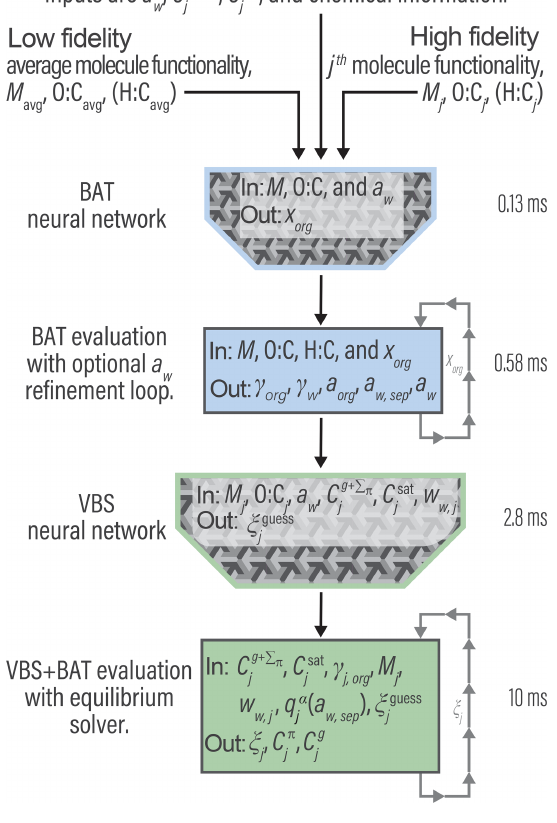
Figure 6. High-level program outline for the VBS + BAT model, including the use of two artificial neural networks. The listed times represent time per single evaluation call, averaged over 13000 ran- dom simulations for a system comprised of 11 species. The H : C value, used in the component density calculation, is estimated when not given (see Sect.